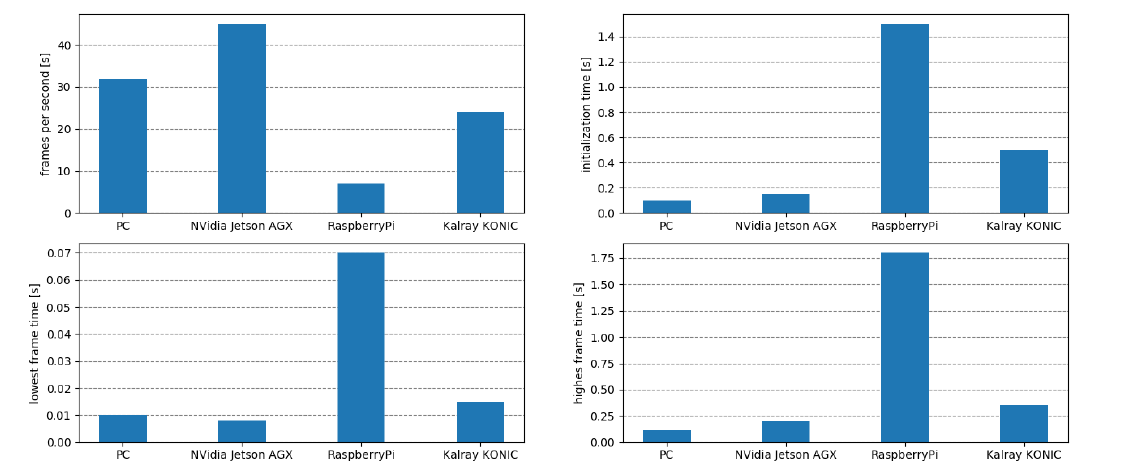
Figure 10. Real-time performance metrics obtained on different deployment ECU devices. The diagrams show the Frames per Second (FPS), AI Inference Engine initialization time, as well as the lowest and highest achieved framerate for four different